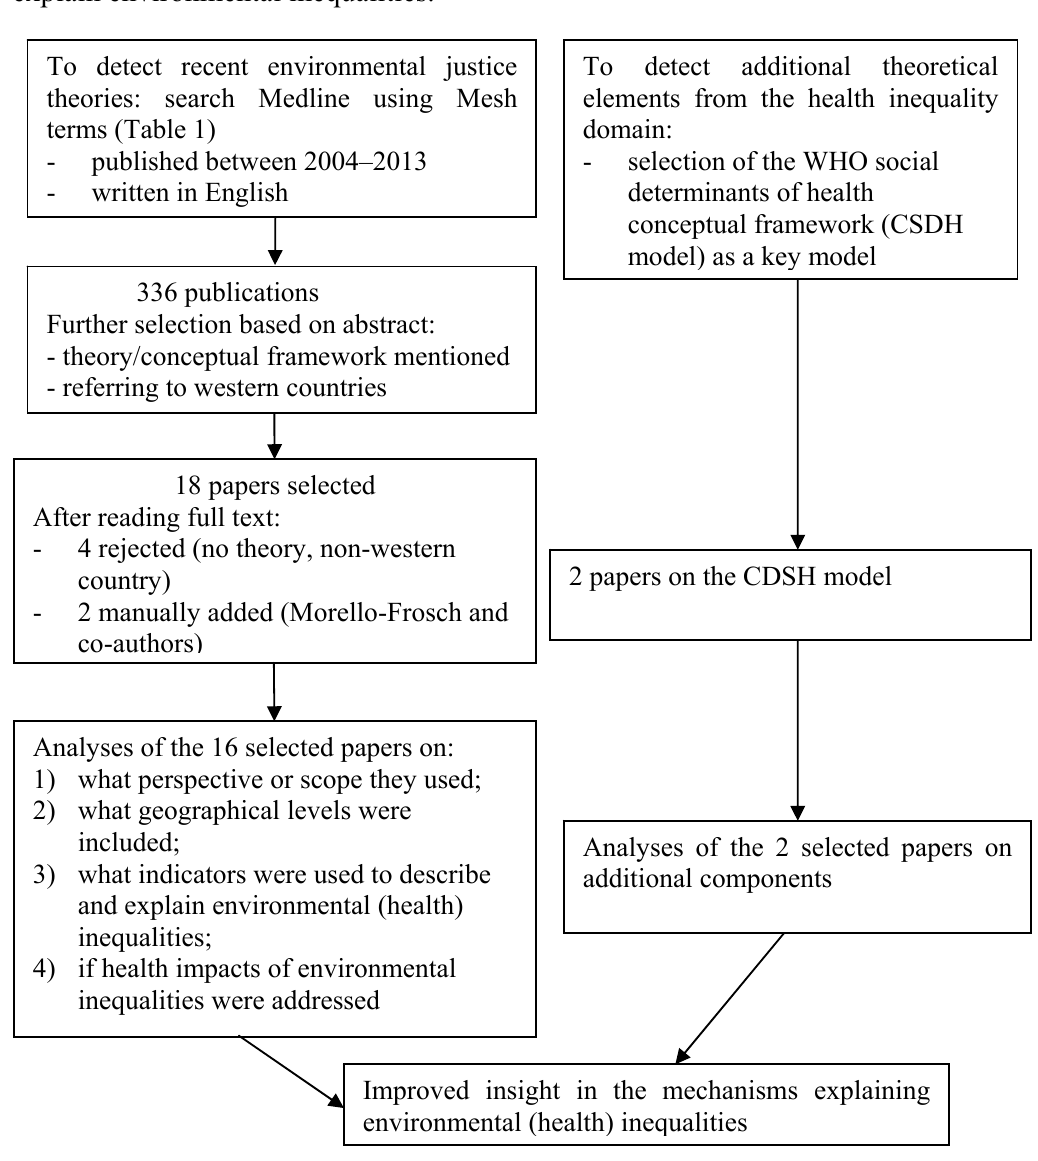
Figure 1. Flowchart on methodology of the pragmatic review on concepts and theories to explain environmental